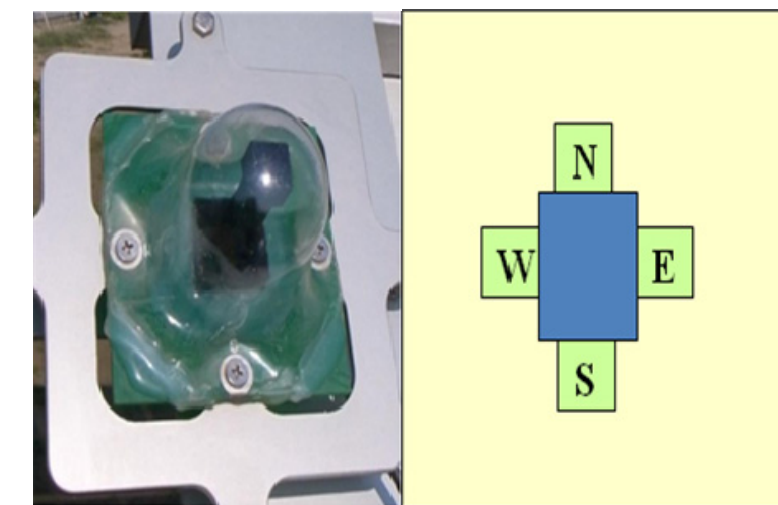
Figure 3. Sun position